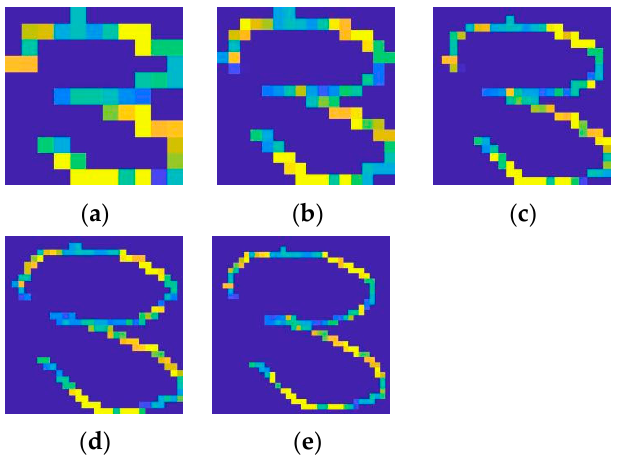
Figure 8. Trajectories of different sizes of air writing digits “3”: ( a ) Size = 10; ( b ) Size = 16; ( c ) Size = 22; ( d ) Size = 28; ( e ) Size = 34.